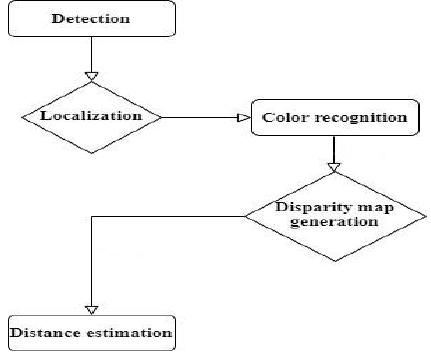
Figure 1. shows the flow of integrated